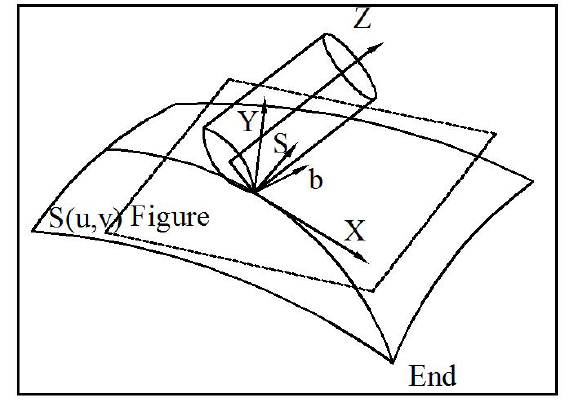
Fig. 2. Algorithm conversion of surface